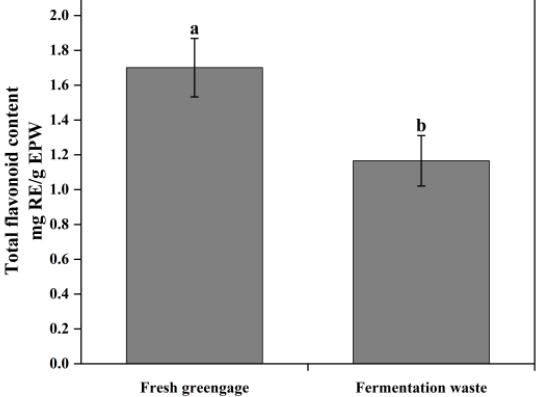
value of 2.5 mg QE (Quercetin Equivalent)/g FW for yellow plum and 2.3 mg QE/g FW for red plum [18].